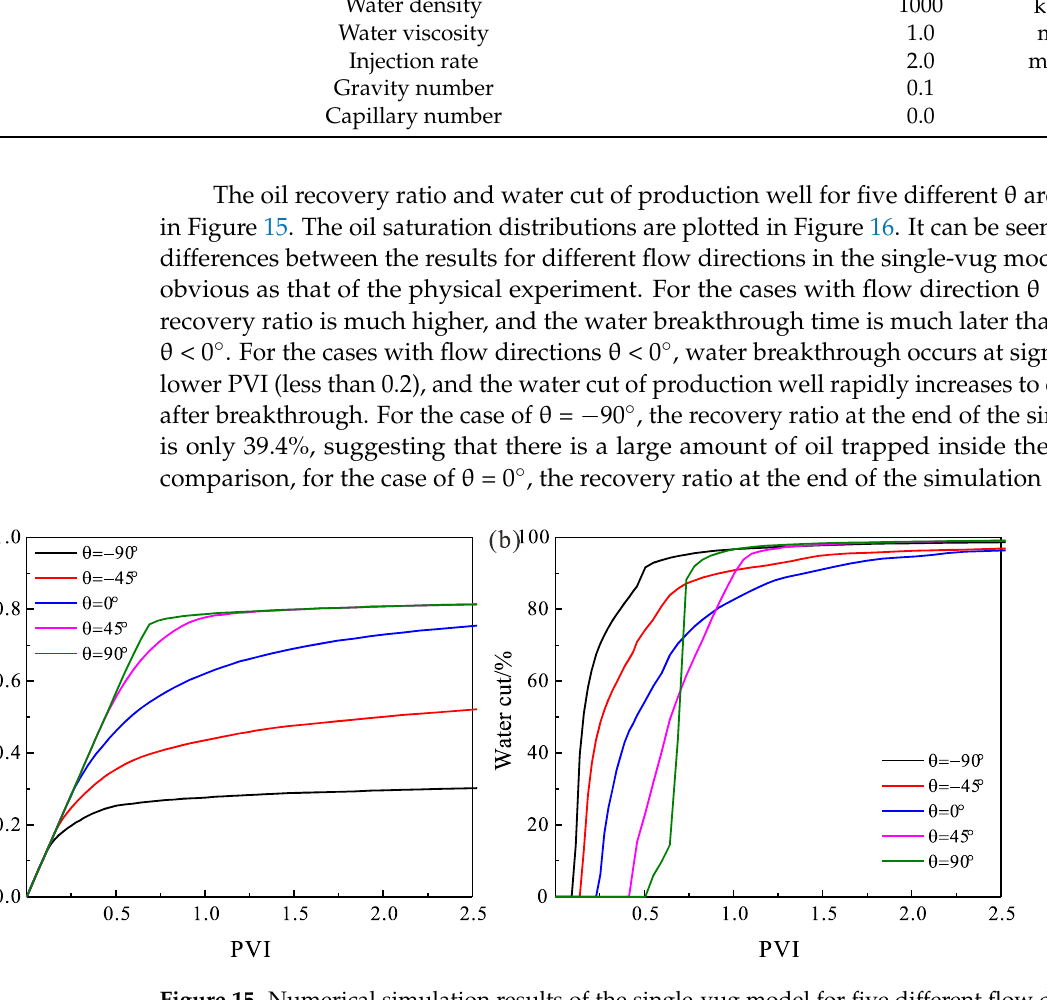
Figure 16. Oil saturation distribution in the single-vug model for five different flow directions.